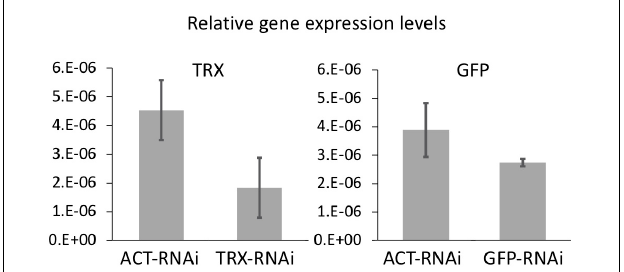
FIGURE 1 | The mean value of GFP and TRX expression levels in control and each dsRNA-treated corals measured by quantitative real-time PCR. Coral treated with actin (ACT) ds-RNA was used as a control to confirm gene-specific RNAi. Corals incubated for 3 days after RNAi treatment were used. Expression levels were normalized to the expression levels of two reference genes (elongation factor and β -tubulin). Experiments were conducted in triplicate with 50 planula larvae each. Error bars are standard error.